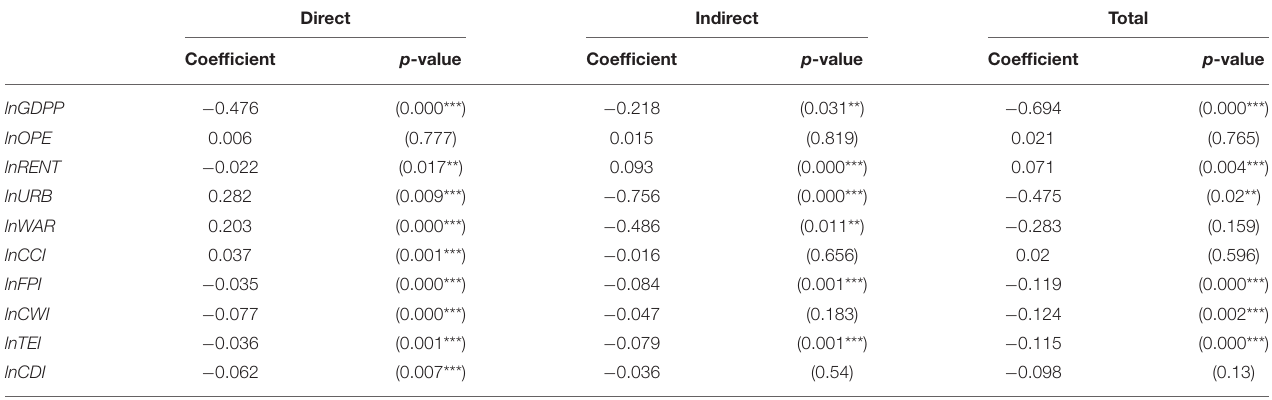
TABLE 7 | Marginal effects of the maternal mortality